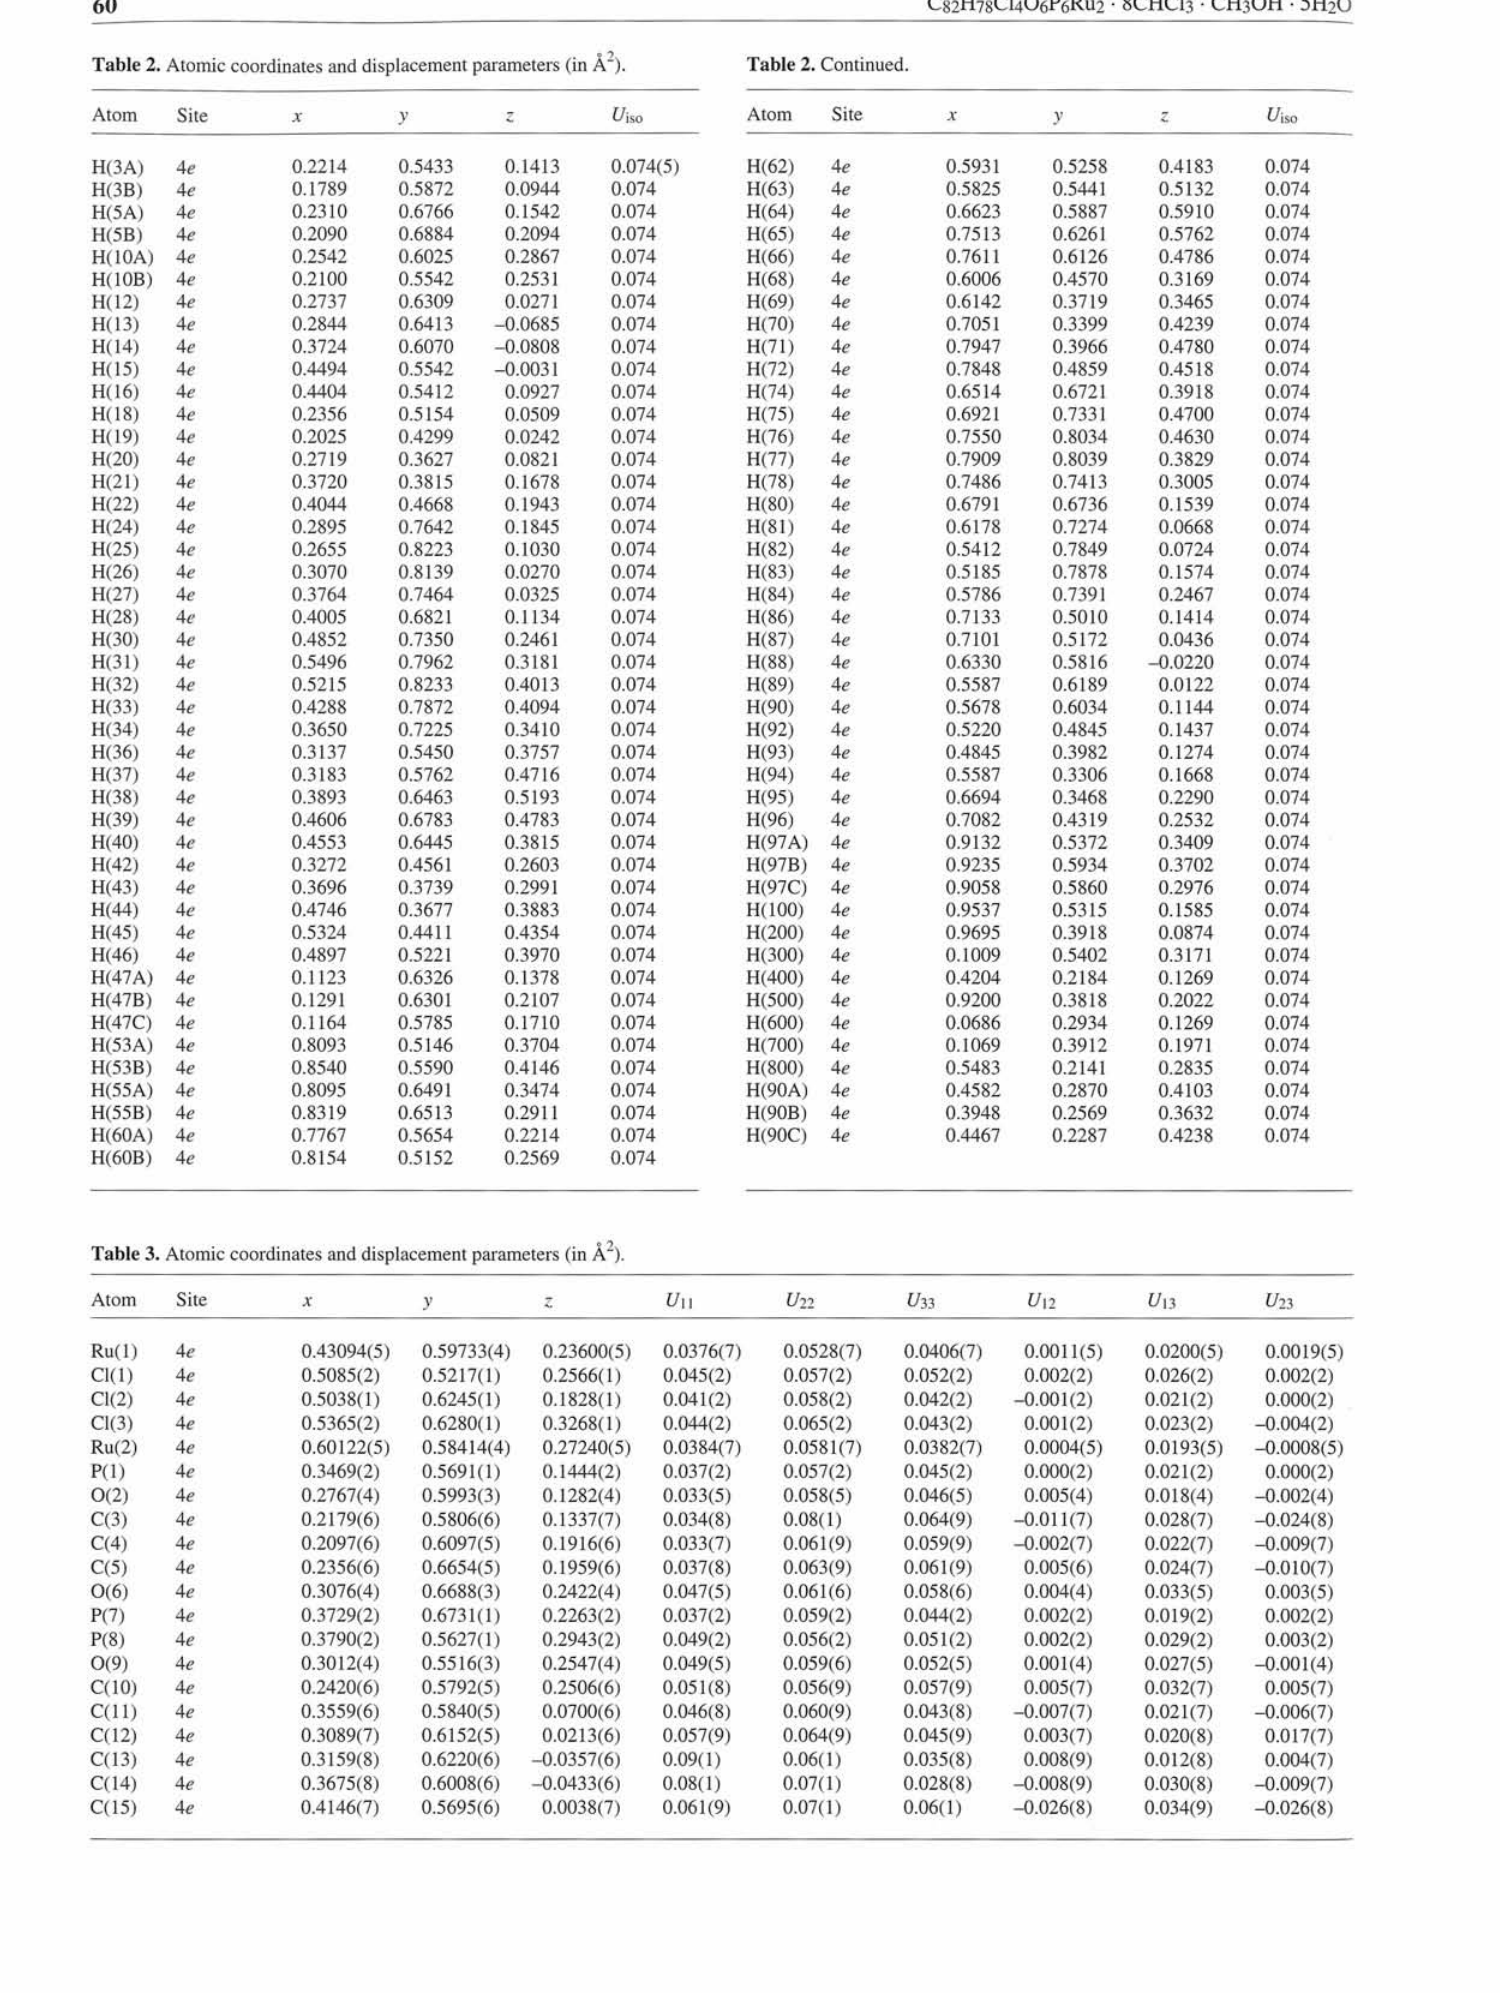
Table 3. Atomic coordinates and displacement parameters (in Â 2